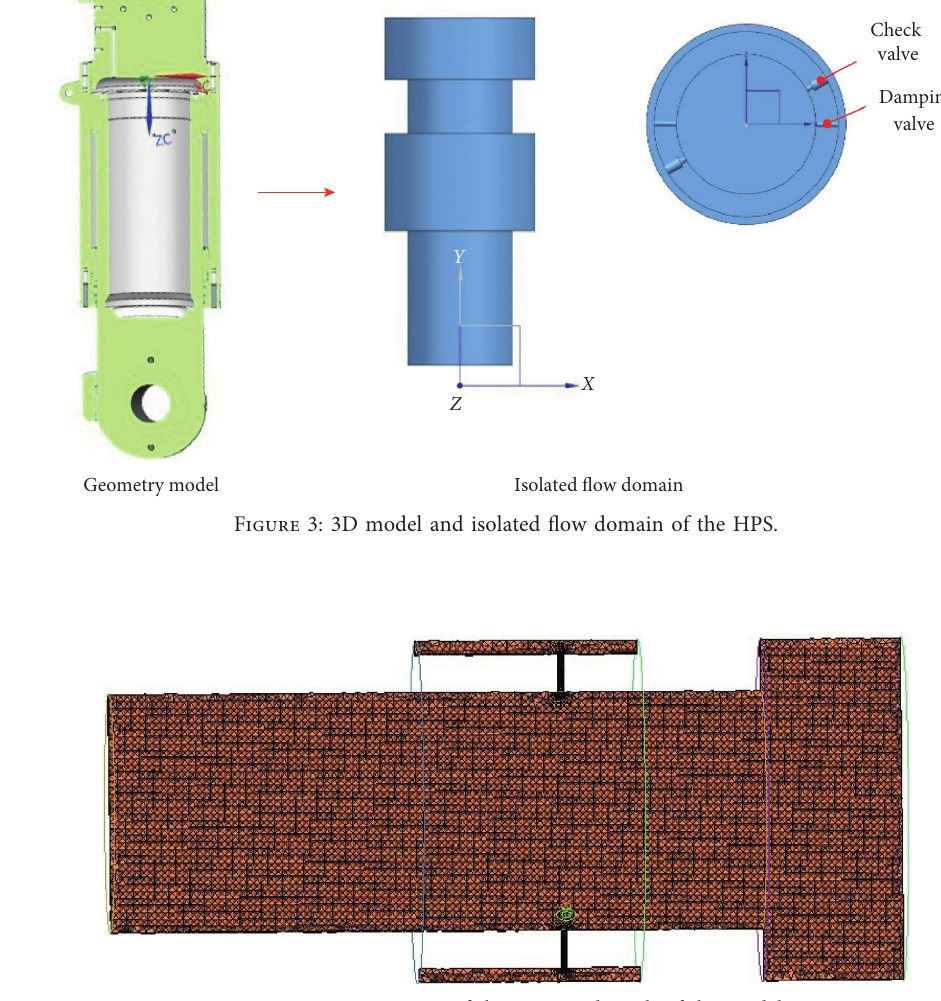
Figure 4: Cross-section of the generated mesh of the model. Table 2: VOF model